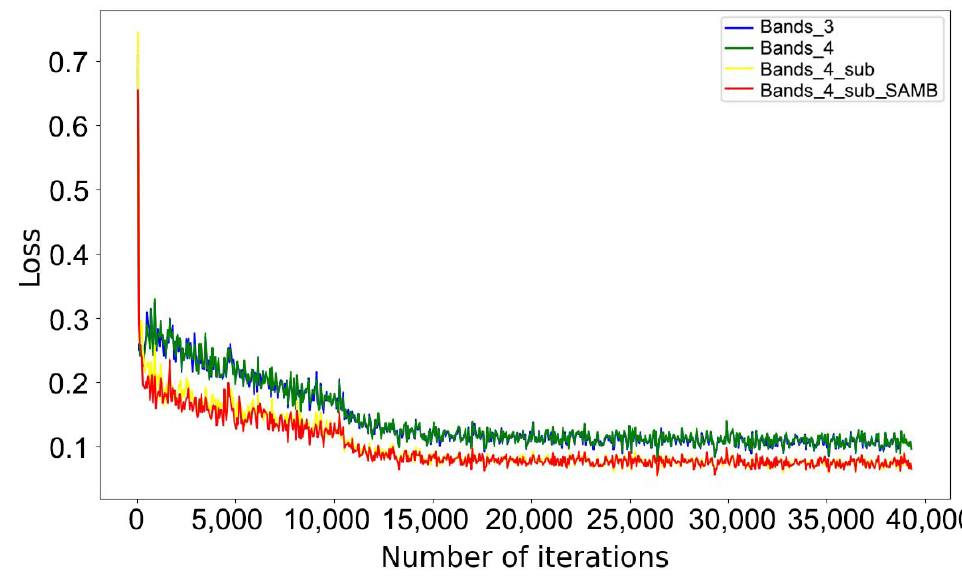
Figure 7. Training loss curves for different models.